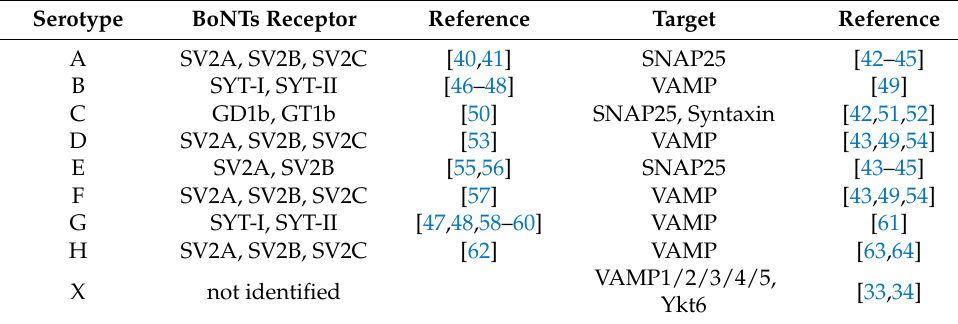
Table 1. BoNTs serotypes characteristics.